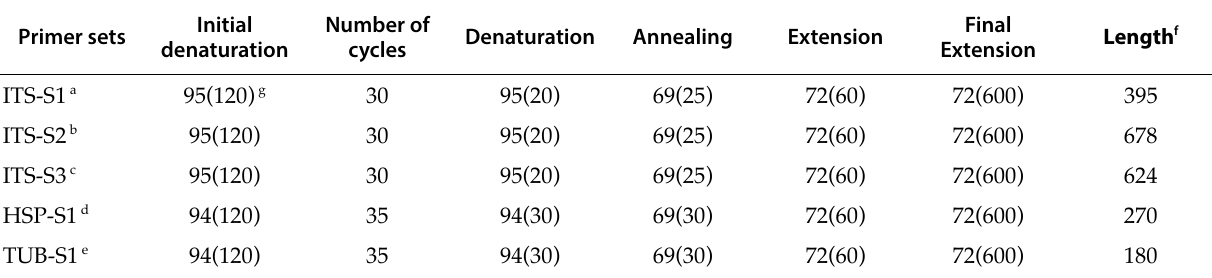
Table 6. Optimized PCR conditions for Phytophthora pistaciae putative species-specific primer pairs and their amplicon